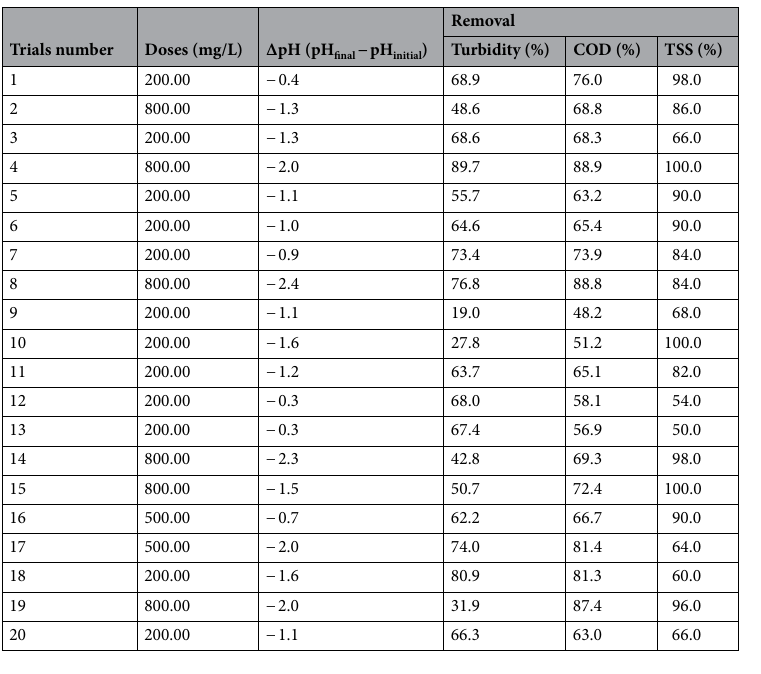
Table 3. Ceramic industry water physicochemical characterization after the coagulation treatment.